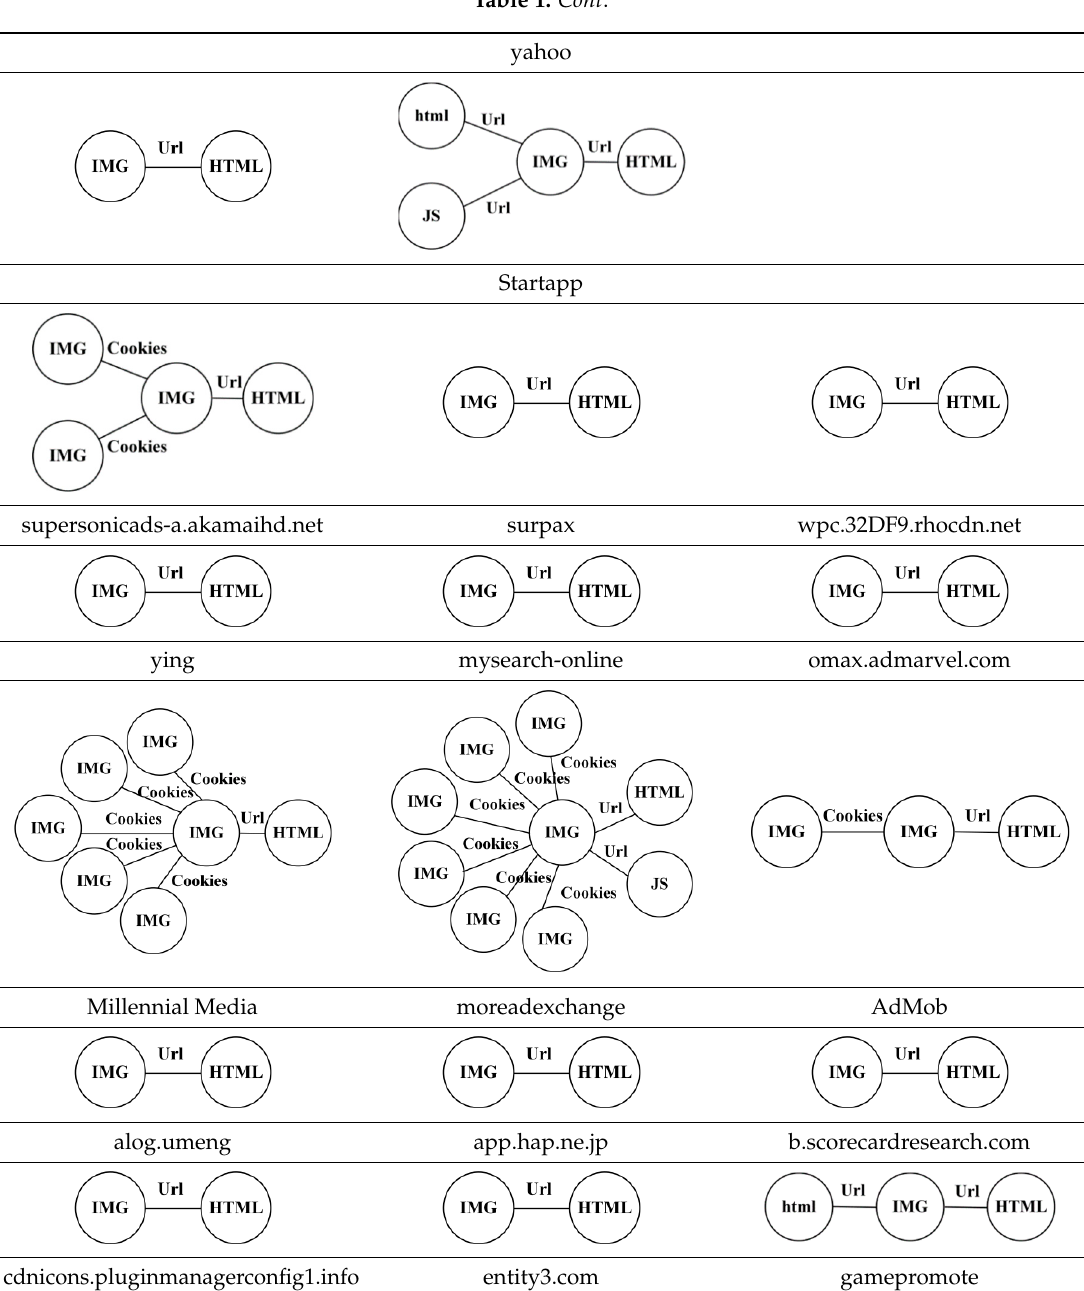
Table 1. Cont . Figure 5. Ad libs’ network behaviors and their graph representations ( a ) MoPub, ( b ) Mmate, ( c ) Hap-game, ( d ) Millennial Media, ( e ) AppLovin. Table 1. Advertising behavior graphs of ad libs (with ad lib as index).